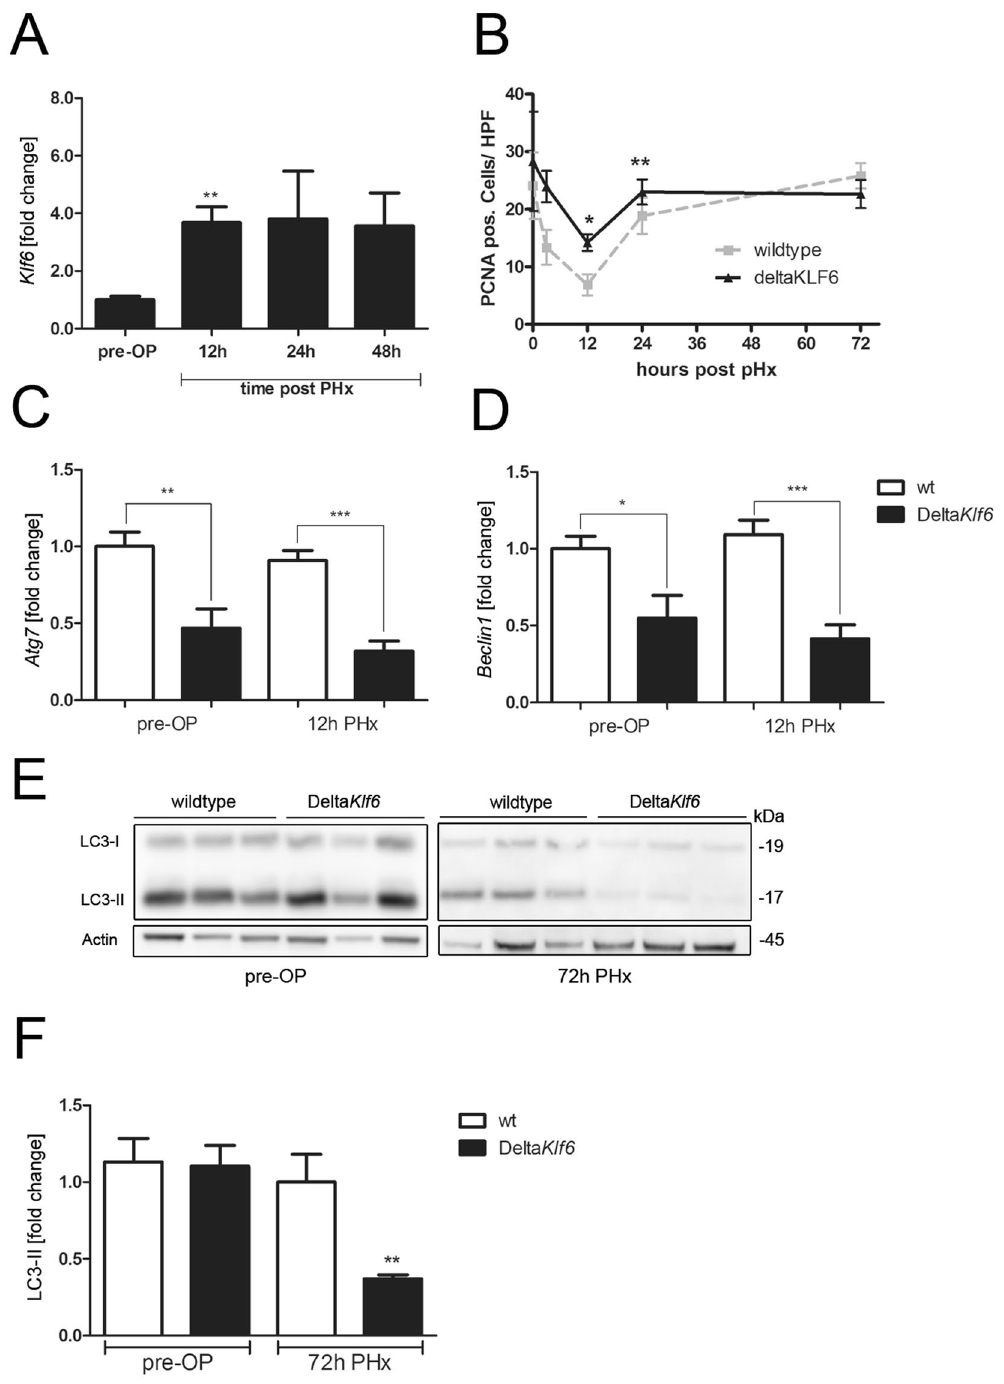
Figure 2. KLF6 affects liver regeneration and expression levels of autophagy-related genes after partial hepatectomy (PHx). Klf6 expression levels were determined by qRT-PCR in mouse liver tissue before (pre-OP) and 12 h, 24 h or 48 h after 70% partial hepatectomy (PHx, n = 6/group) ( A ). Cell proliferation was assessed by quantification of PCNA positive cells in liver tissue of wildtype (wt) and Delta Klf6 mice 72 h after PHx ( B ). Expression-levels of Atg7 ( C ) and Beclin1 ( D ) were measured by qRT-PCR in liver tissue of wt and Delta Klf6 mice before and 12 h after PHx. Autophagy was assessed by LC3 Western blotting and quantified by densitometry of specific protein bands ( E , F ) in liver tissue of wt and Delta Klf6 mice 72 h after PHx. Shown are representative Western blot images ( E ) and densitometric quantification of LC3-II-bands normalized to loading control beta-Actin ( F ); fold change versus control shown as mean ± SEM of n = 6 mice per group; full length Western blot images are given in Supplementary information). * Represents p-value < 0.05 and ** Indicates p-value < 0.01 as assessed by 2-way ANOVA comparing wt mice with Delta Klf6 animals at the same time point after